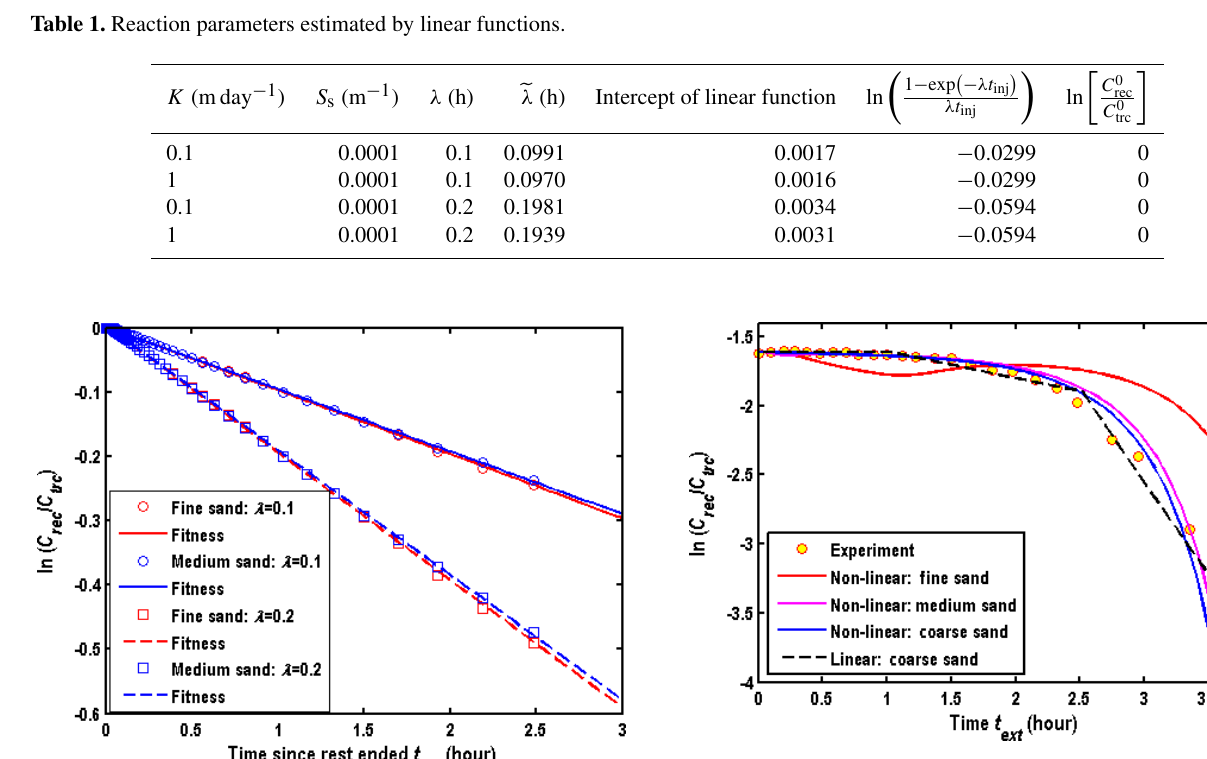
Figure 11. Computed ln (cid:2) C rec /C tra (cid:3) ∼ t ∗ by the model of this study using a nonlinear function to describe the nonlinear chemical reac-